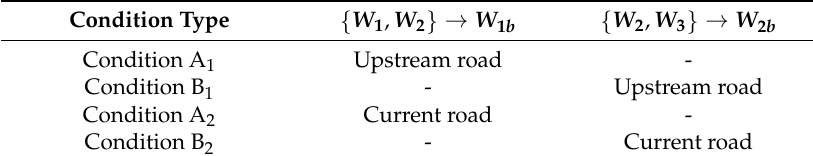
Table 2. Evaluation of the sub-conditions of shockwave propagation.